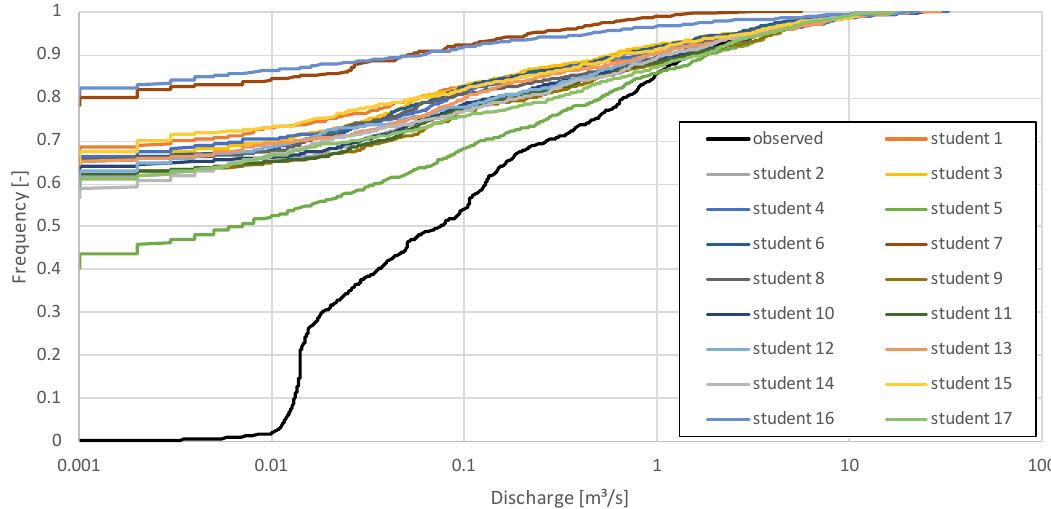
Figure 4. Flow duration curve based on observed (black) and simulated discharge for the whole simulation period.